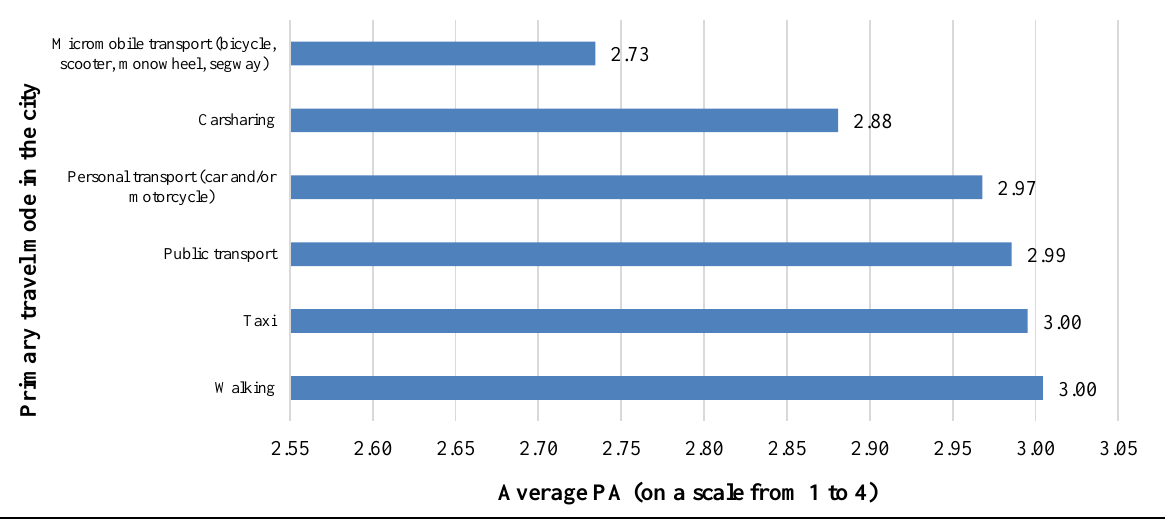
Figure 7. Relationship between the respondent's primary transport mode and PA.